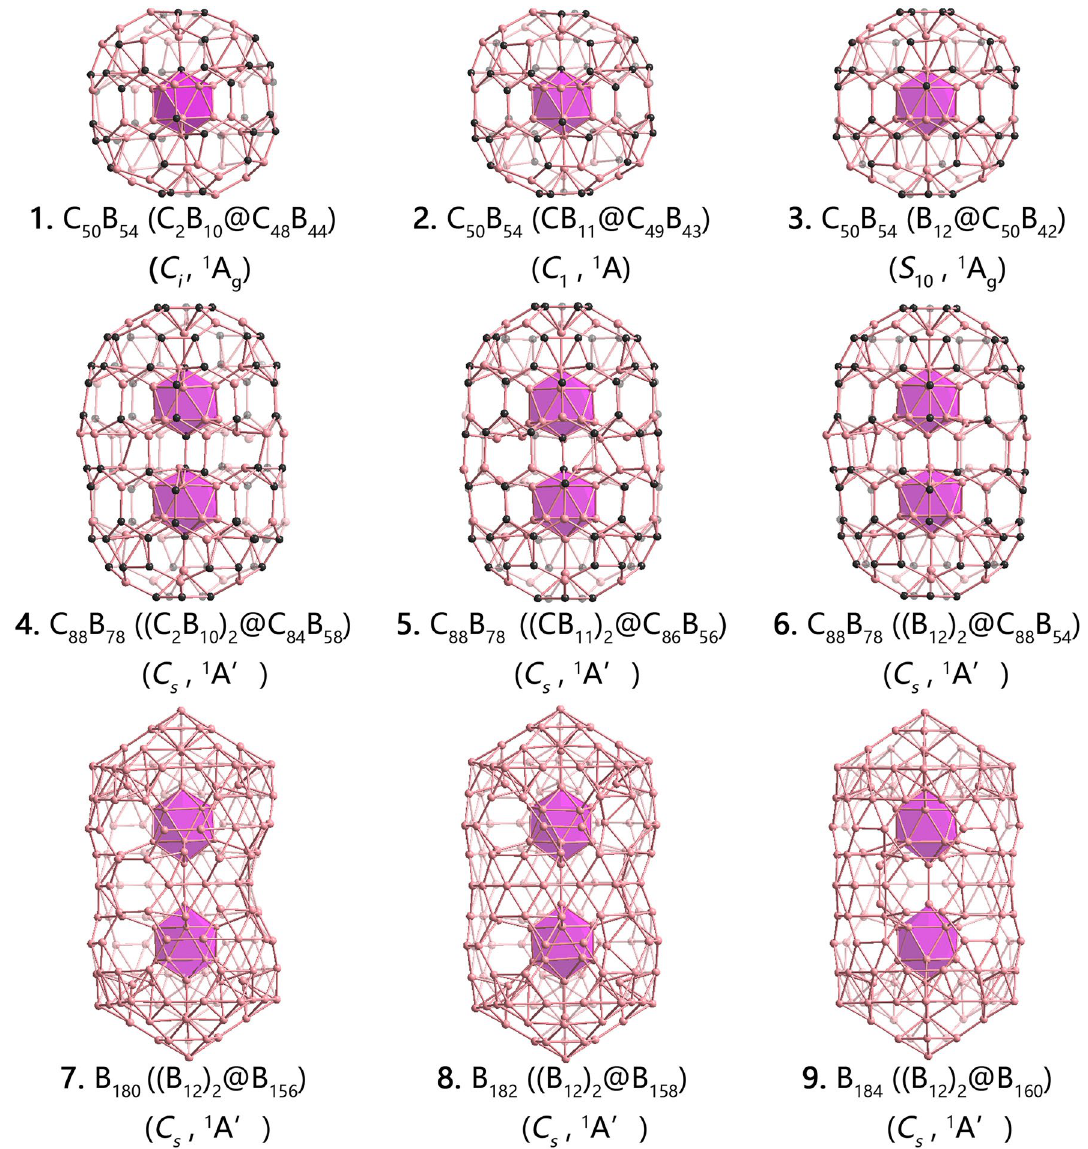
Figure 1. Optimized structures of C i C 50 B 54 ( 1 ), C 1 C 50 B 54 ( 2 ), S 10 C 50 B 54 ( 3 ), C s C 88 B 78 ( 4 ), C s C 88 B 78 ( 5 ), C s C 88 B 78 ( 6 ), C s B 180 ( 7 ), C s B 182 ( 8 ), and C s B 184 ( 9 ) at PBE0/6-311G(d) level, with the icosahedral-C n B 12- n ( n = 0, 1, 2) cores at the centers highlighted in